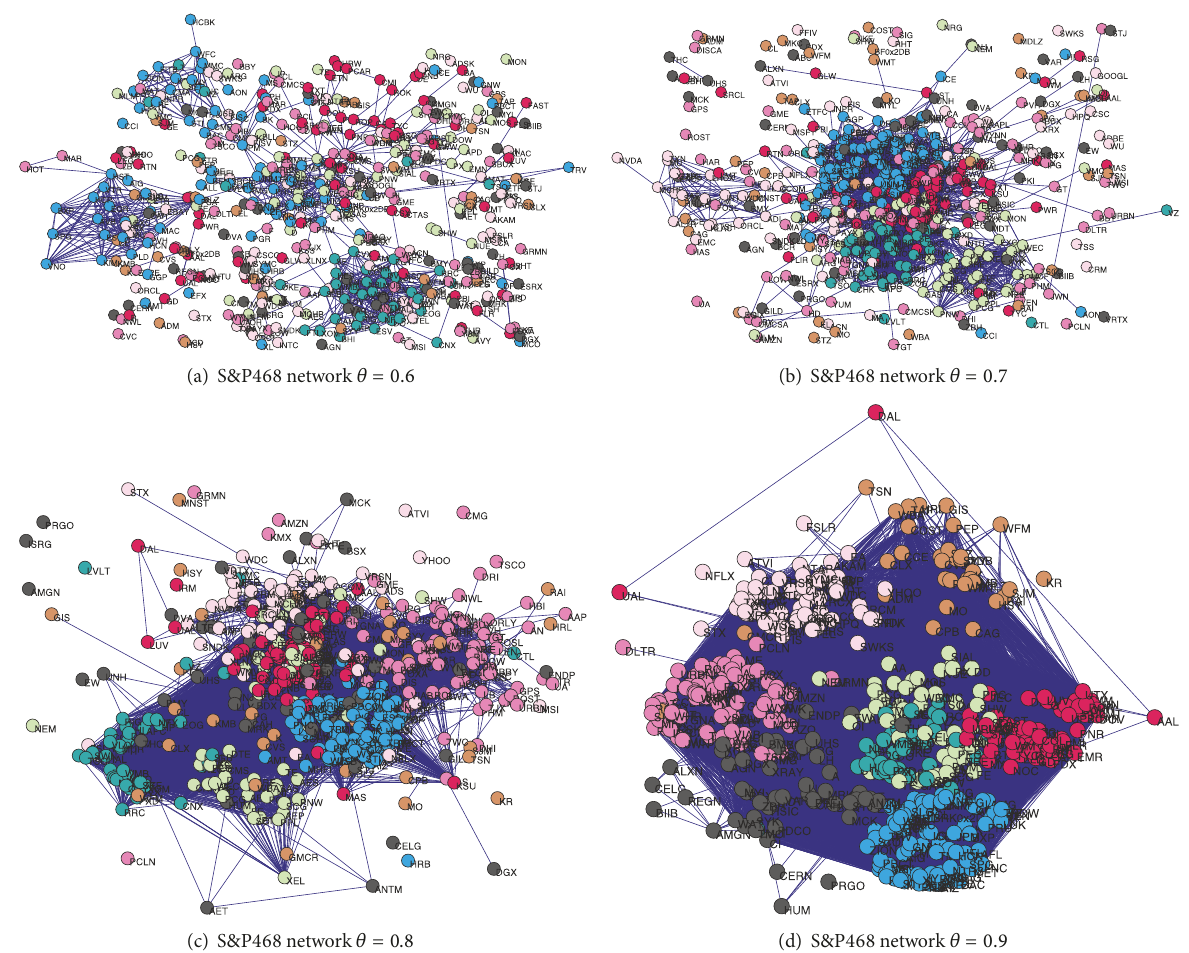
Figure 8: S&P468 networks with different 𝜃 of 0.6 (a), 0.7 (b), 0.8 (c), and 0.9 (d). It also shows that the edge densities with different 𝜃 change dramatically. We find that the edge density when 𝜃 = 0.9 is 68.79 times to that when 𝜃 = 0.6 . Different vertexcolors indicatedifferent industry